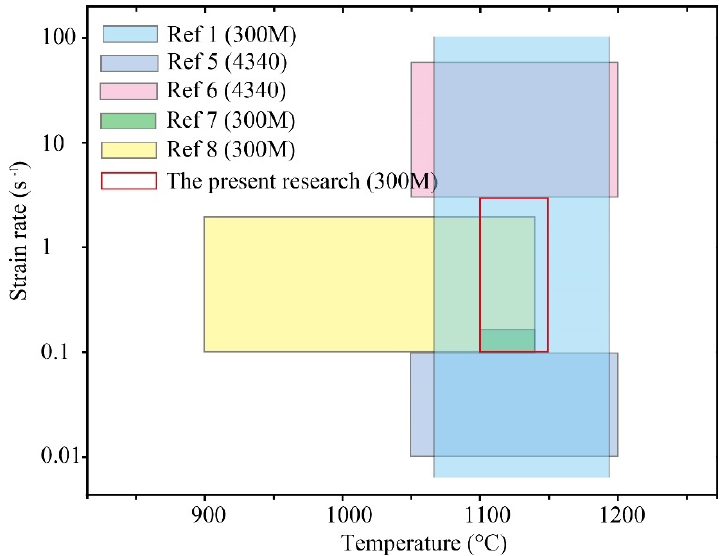
Figure 12. Comparison of the optimal hot working parameters in the present research with the optimal parameters in the literature.